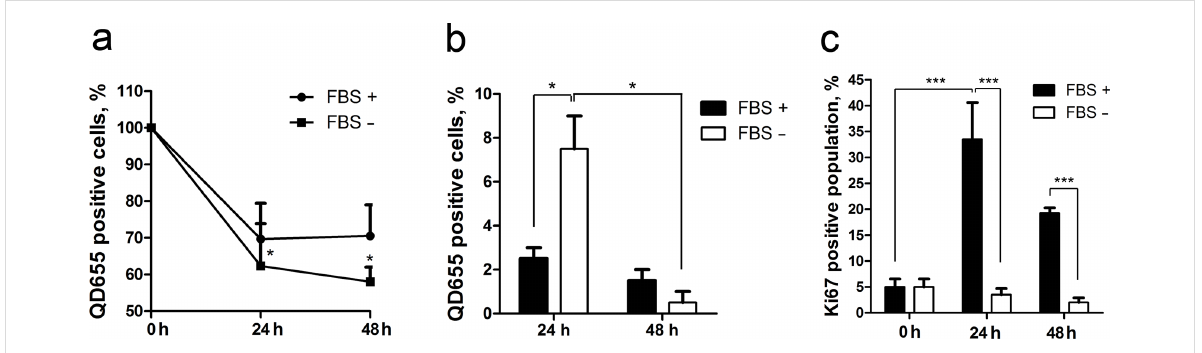
Figure 3: The release of QDs from MSCs. (a) QD loss in complete medium (FBS +) and serum-free medium (FBS − ) after primary QD labelling (0 h) and 24 and 48 h after labelling. The statistical significance is shown in comparison to 0 h. (b) Secondary QD labelling of MSCs by supernatants from primarily labelled MSCs. (c) The comparison of Ki67 expression in complete and serum-free medium after labelling (0 h) and after 24 h and 48 h of cultivation; *p-value < 0.05, ***p-value < 0.001.